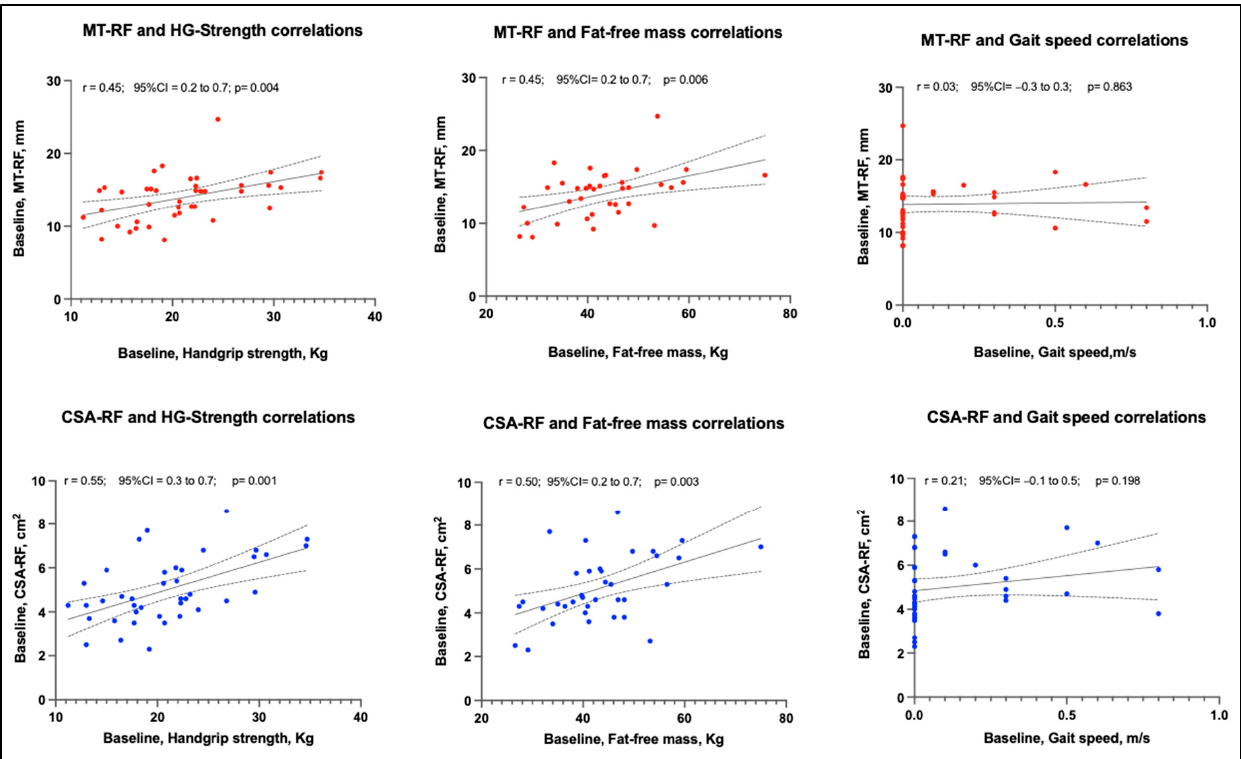
Figure 4. The relationship of baseline muscle thickness and cross-sectional area of rectus femoris